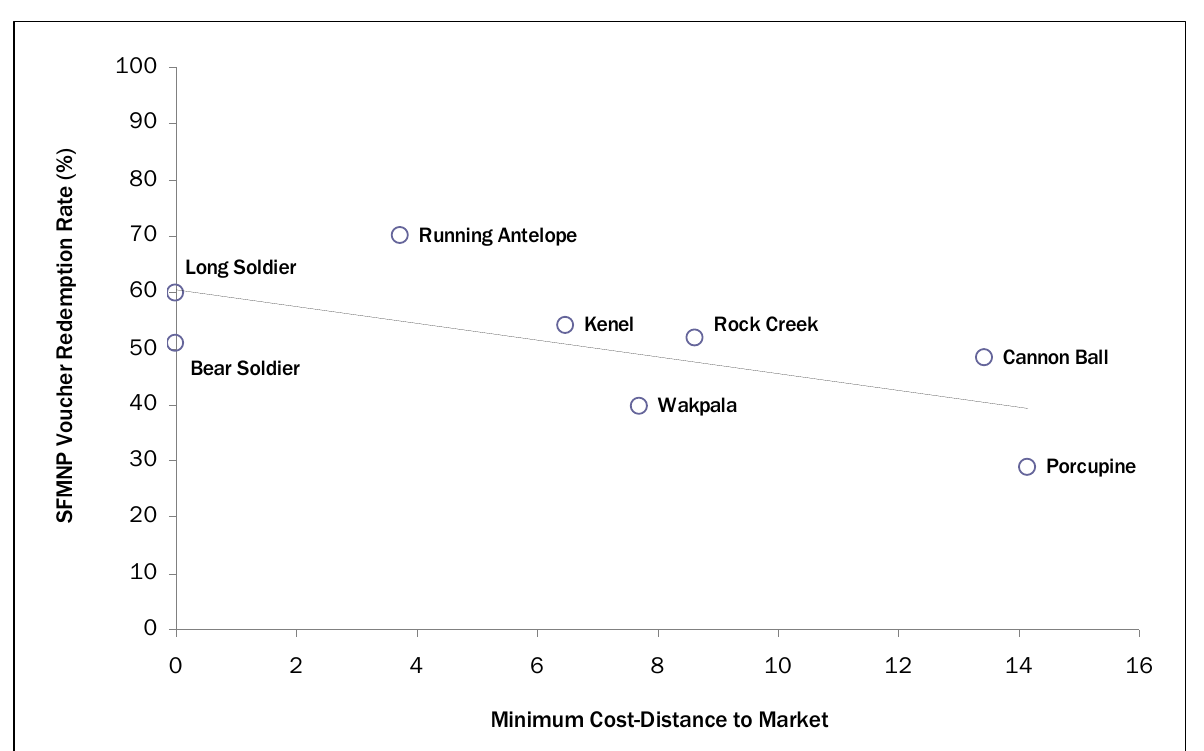
Figure 4. Effect of Minimum Cost-Distance to Market on Voucher Redemption Rates